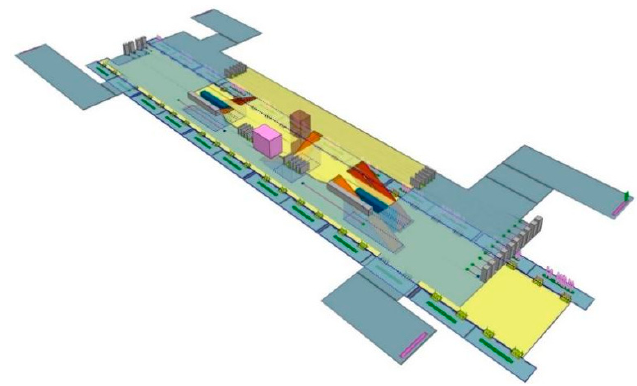
Figure 3. The concourse floor in the Massmotion model.